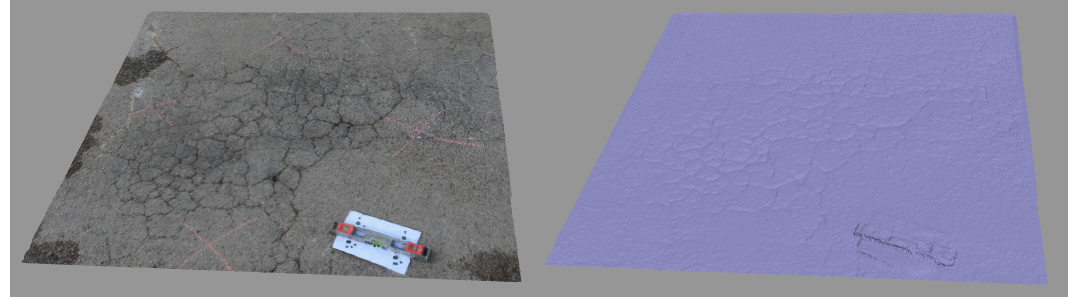
Figure 12. Model of distress 3 ( right ) and dense cloud ( left ) produced by imagery from Huawei P20 Pro.